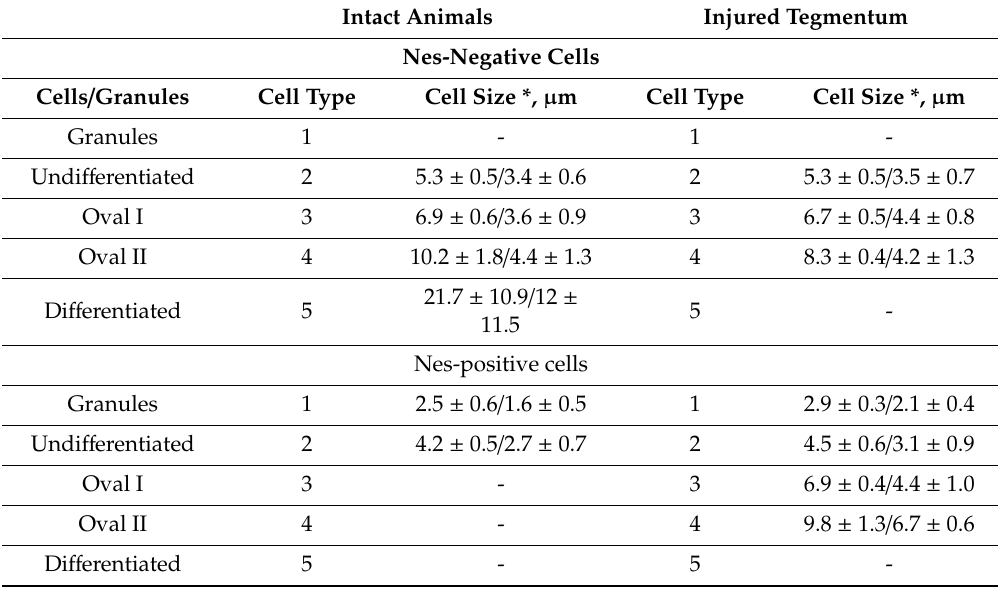
Table 2. Morphometric characteristics of nestin-labeled cells (M ± SD) in the intact and damaged mesencephalic tegmentum of juvenile chum salmon, Oncorhynchus